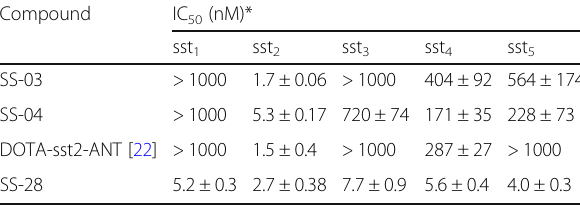
Table 2 Binding affinities (IC 50 , nM) of chelator-peptide conjugates